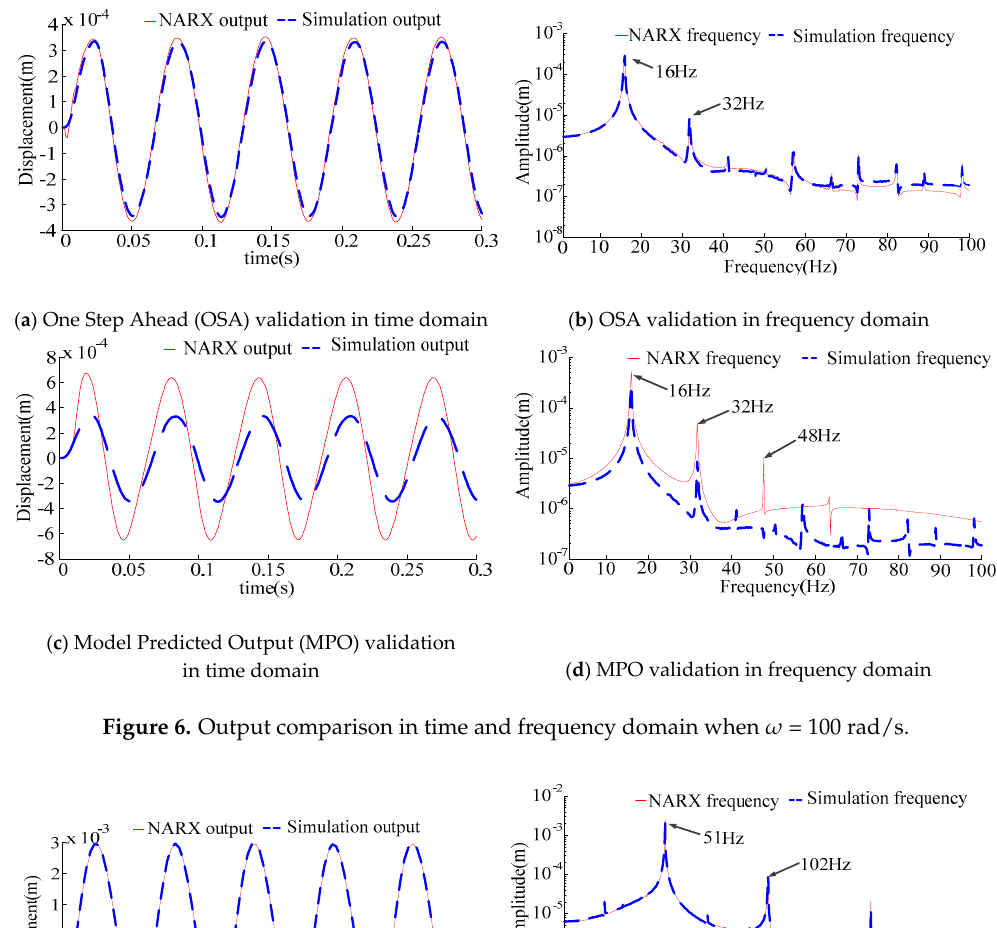
Figure 6. Output comparison in time and frequency domain when ω = 100 rad/s.